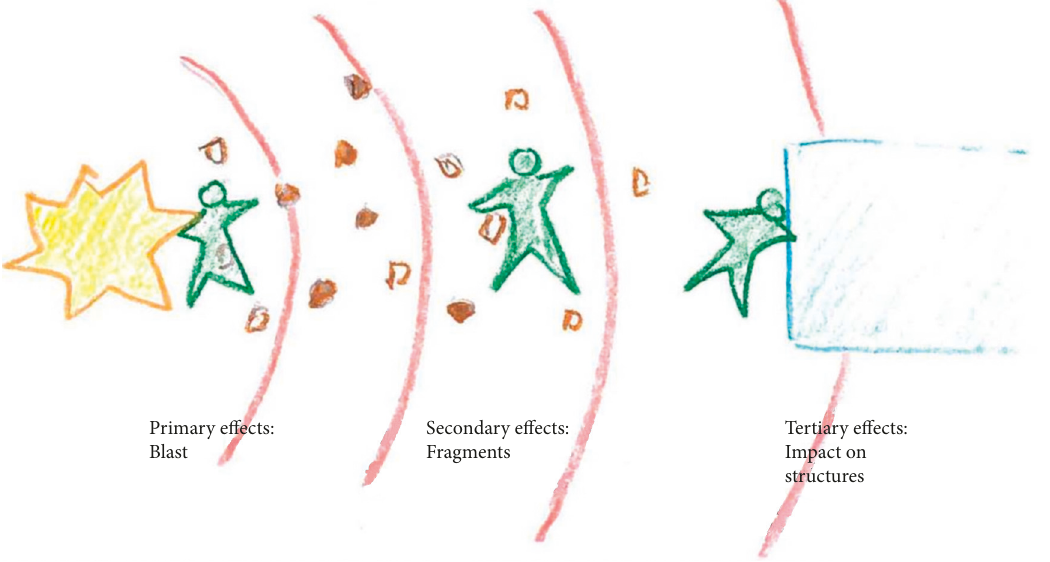
Figure 5: Blast effects of an explosive charge (yellow) on humans (green) due to the created blast wave (red) and fragmentation